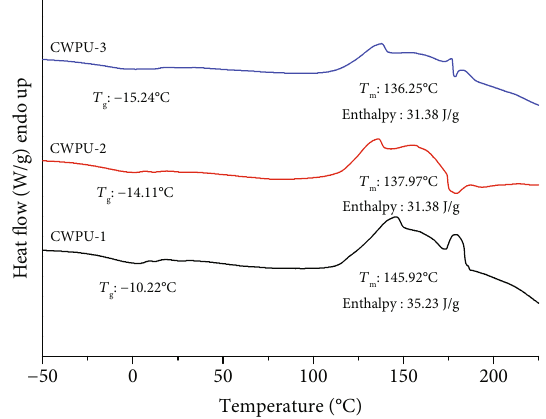
Figure 6: XRD patterns of cationic waterborne polyurethanes (CWPUs) with various internal emulsi fi er contents. Table 3: Degree of crystallinity of cationic waterborne polyurethanes (CWPUs) with various internal emulsi fi er contents. Formula Degree of crystallinity (%)